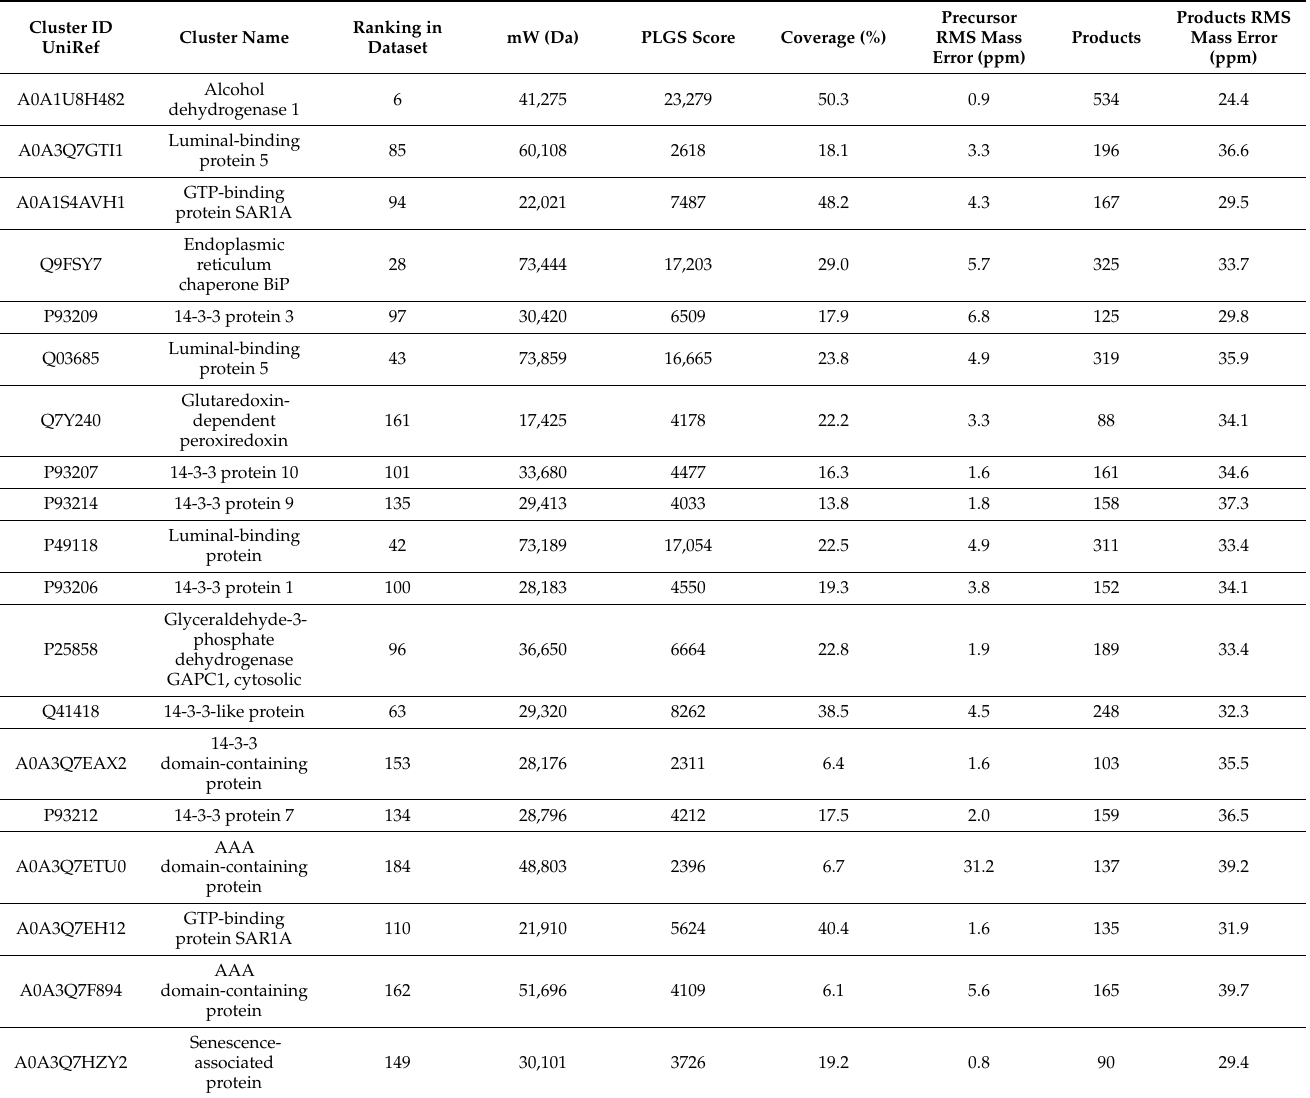
Table 1. Proteins identified with “Regulation of cellular processes” gene ontology (GO) term (GO:0050794) in Fraction 8 (visible Band 2) of the density gradient ultracentrifugation separated tomato fruit-derived nanovesicles (data extracted from Tables S1 and